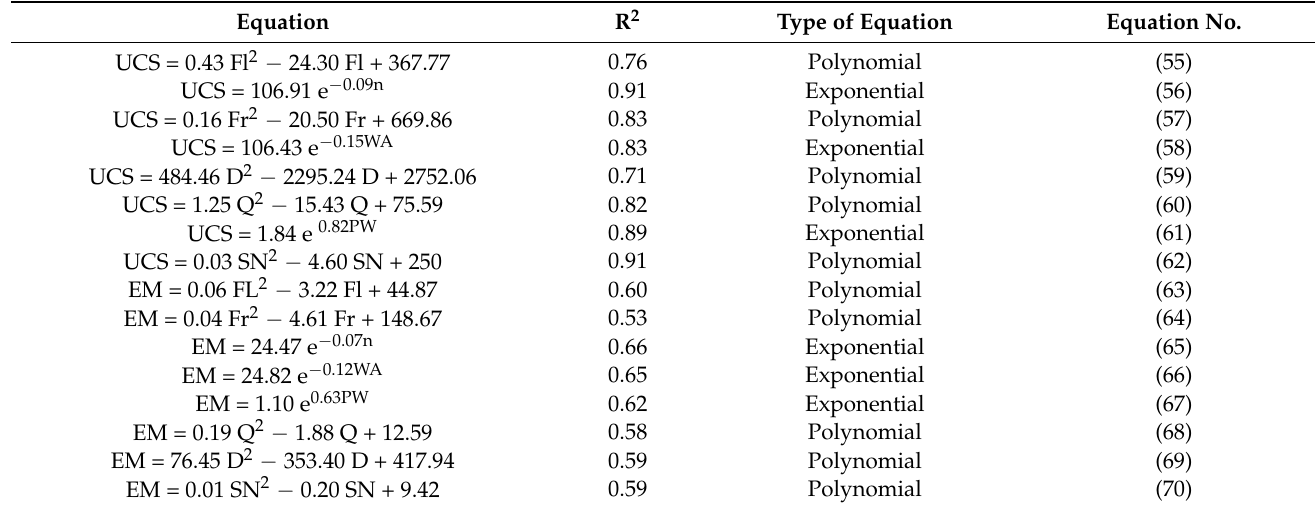
Table 8. Most accurate nonlinear regression between variables.